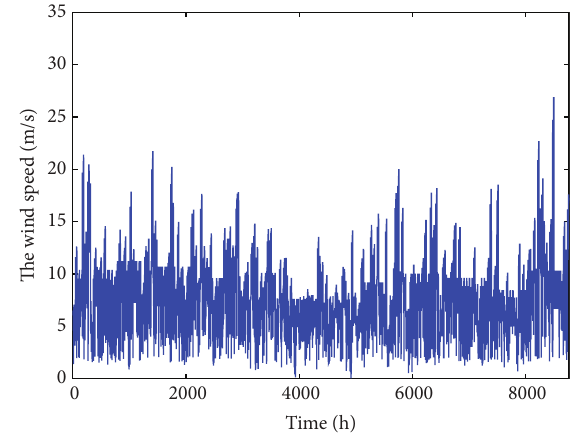
Figure 5: The speed distribution of the